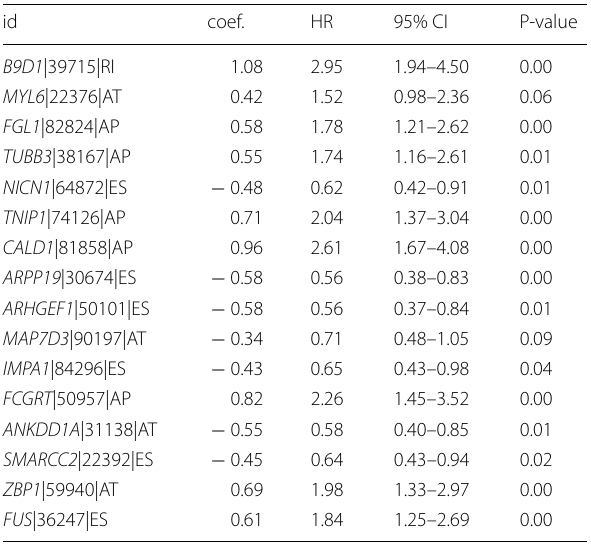
Table 2 Identification of specific differentially expressed AS events involved in final prognostic signature by multivariate